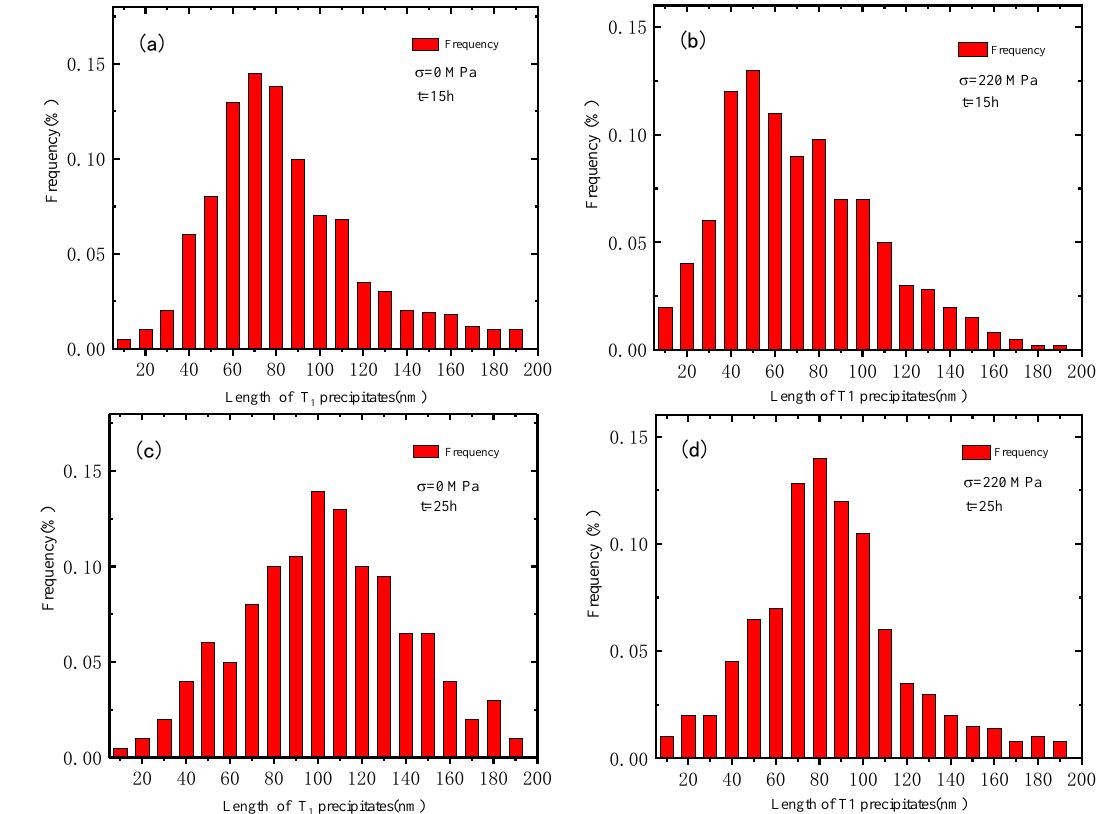
Figure 7. Diameter distribution of T1 phase of Al-Li-S4 aluminum alloy after creep aging at 153 (( a ) σ = 0, t = 15 h; ( b ) σ = 220 MPa, t = 15 h; ( c ) σ = 0, t = 25 h; ( d ) σ = 220 MPa, t = 25 h).